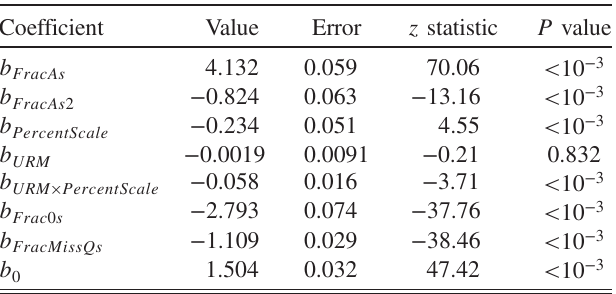
TABLE VII. The coefficients from an HLM fit to Eq. (7) are shown along with their standard errors, z statistics, and P values. Using the fraction of blank answers and the fraction of missed quizzes as control variables we find that the basic (CLASP4) URM grade penalty, b URM , has been reduced to nearly zero but the extra percent scale grade penalty, b URM , has not × PercentScale significantly changed. At the student level this model has SBR 2 ¼ 0 . 76 with SBR 2 ¼ 0 . 35 at the class level.